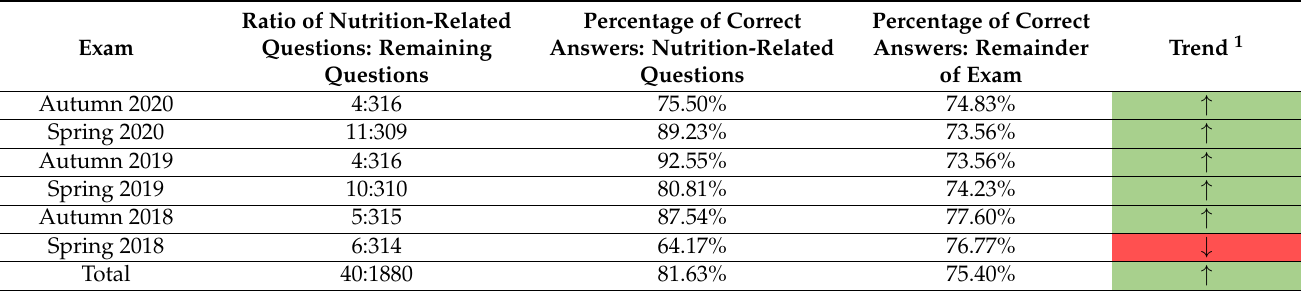
Table 3. Percentage of correct answers: nutrition-related questions vs. remaining exam questions.